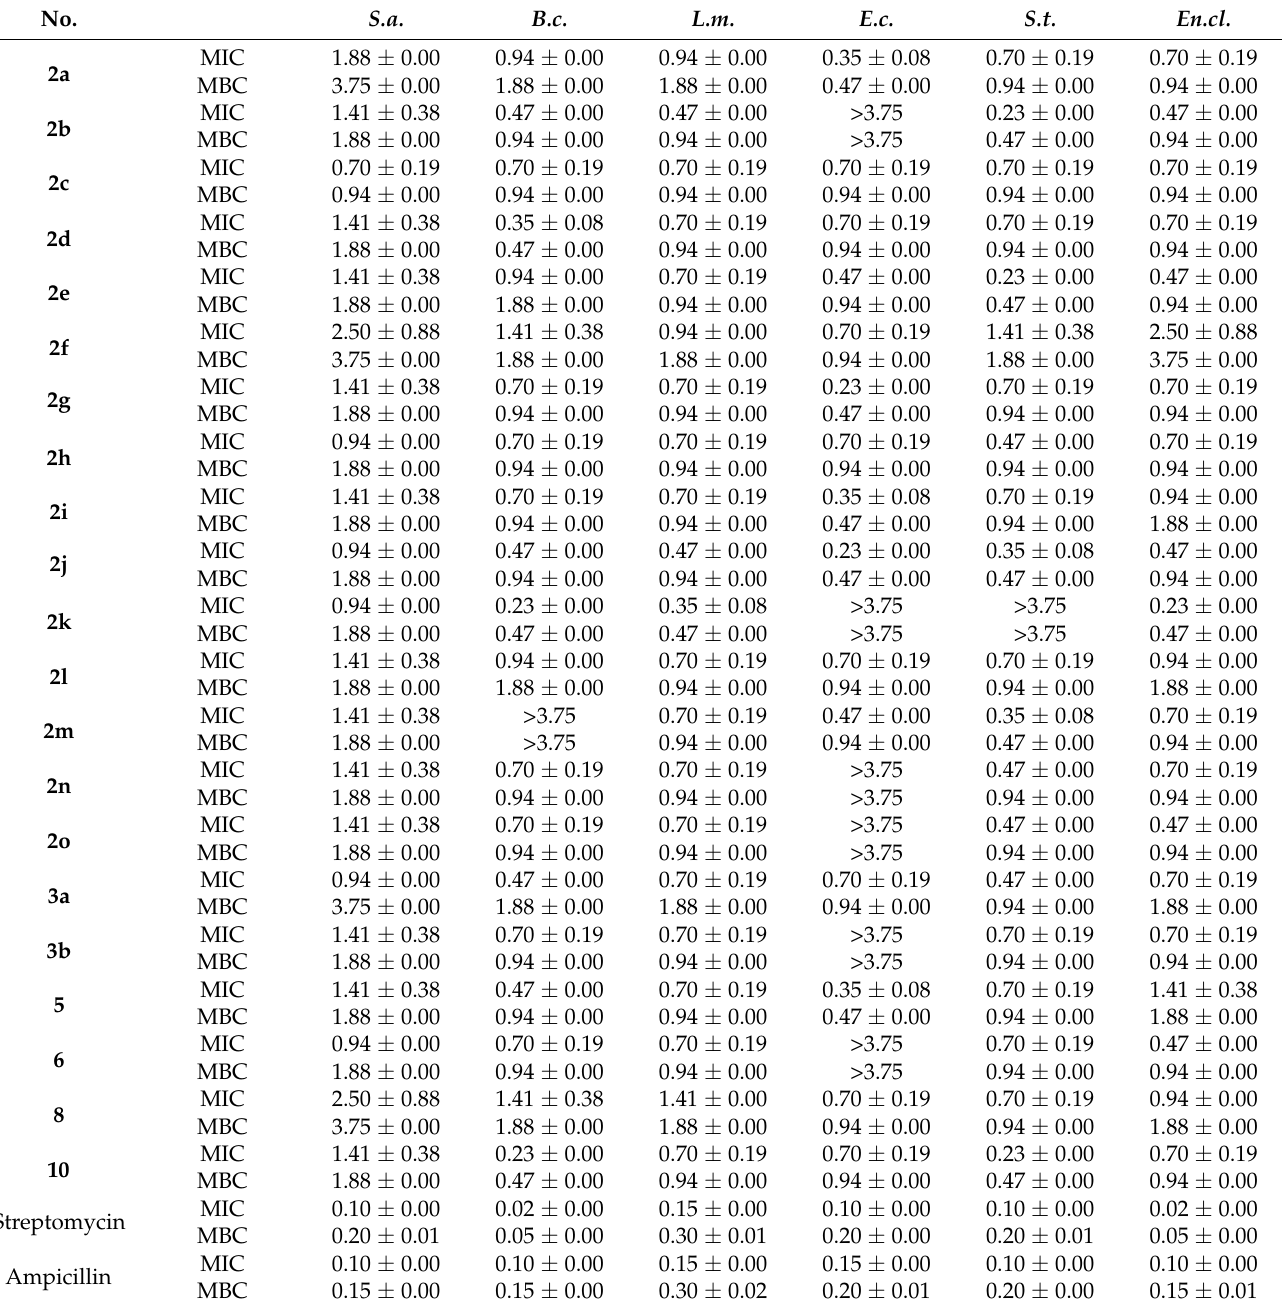
Table 1. Antibacterial activity of heteroaryl derivatives of benzothiazole (mg/mL).